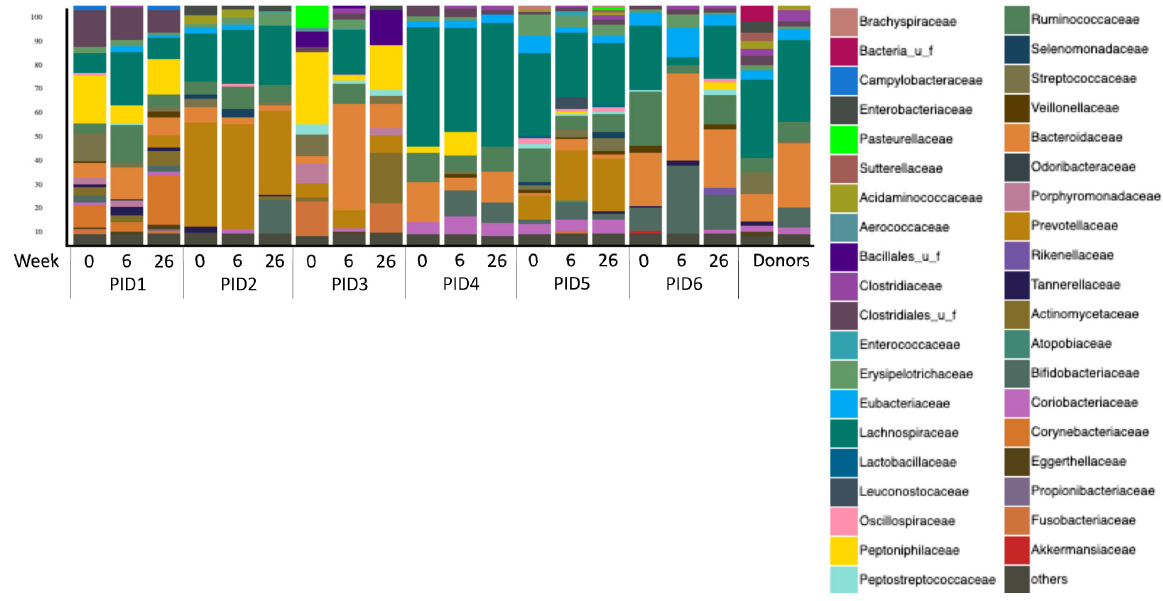
Figure 3. Microbial composition of the participants and donors at the family level. Families with abundance <5% were grouped into “others”